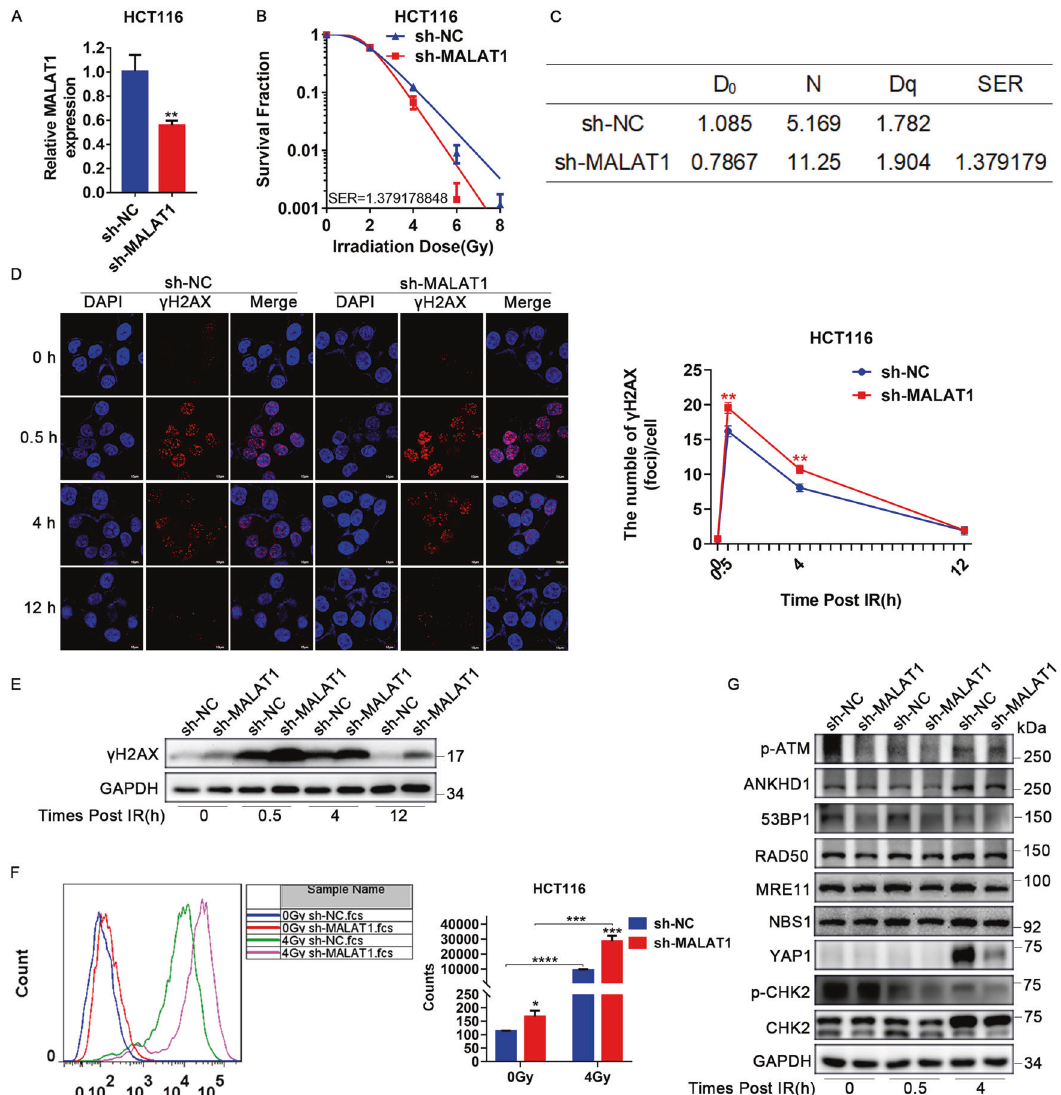
SER = 1.379. C The D 0 , N, Dq and SER values of MALAT1-silenced cells, the SER value was simulated using the multitarget single-hit model. D γ H2AX foci were detected by immuno fl uorescence at 0, 0.5, 4, and 12 h post IR in CHT116 cell, and the number of γ H2AX foci was counted in more than 100 cells (** P < 0.01). E The expression of γ H2AX was tested at 0, 0.5, 4 and 12 h after 4-Gy IR. F The formation of ROS was tested by fl ow cytometry at 0.5 h after 4 Gy IR in MALAT1-silenced HCT116 cells (* P < 0.05, *** P < 0.001). G The expression of p-ATM, ANKHD1,